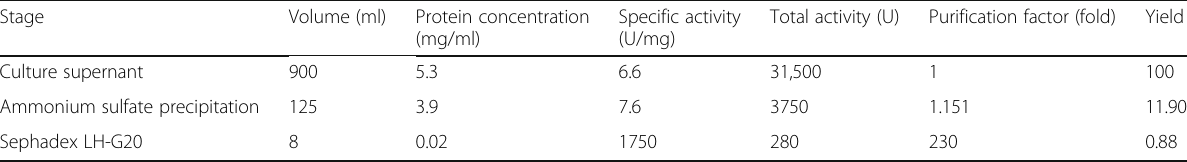
Table 2 Summary of the purification procedure of killer toxin from Wickerhamomyces anomalus